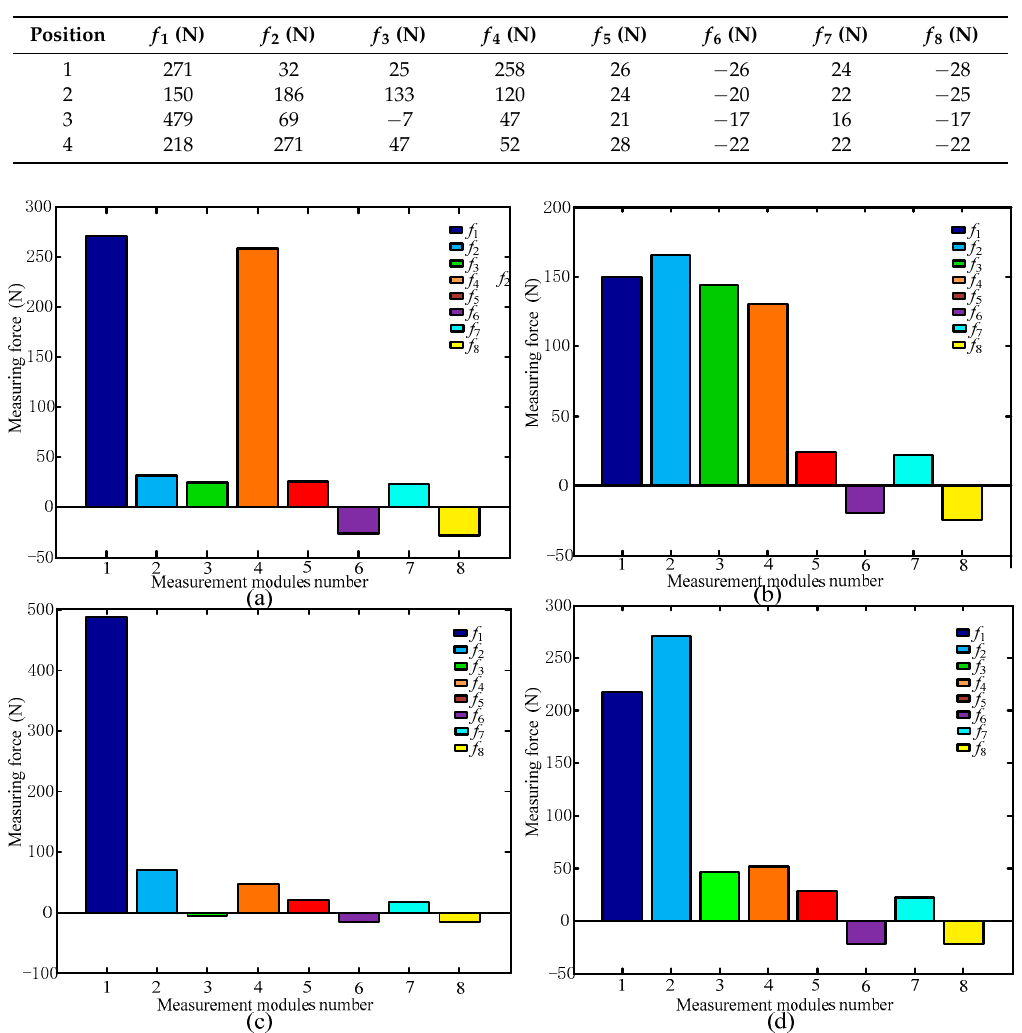
Table 8. Output values of each measurement module in application experiments.